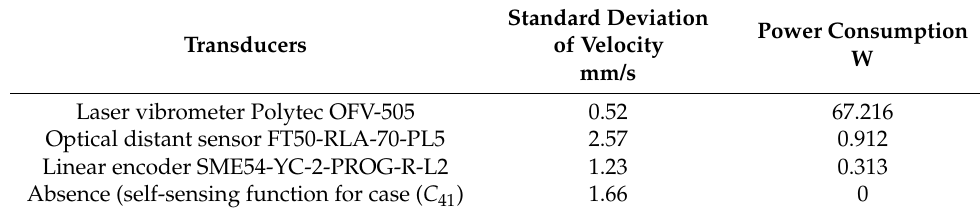
Table 3. The standard deviation of measured velocity and power consumption of